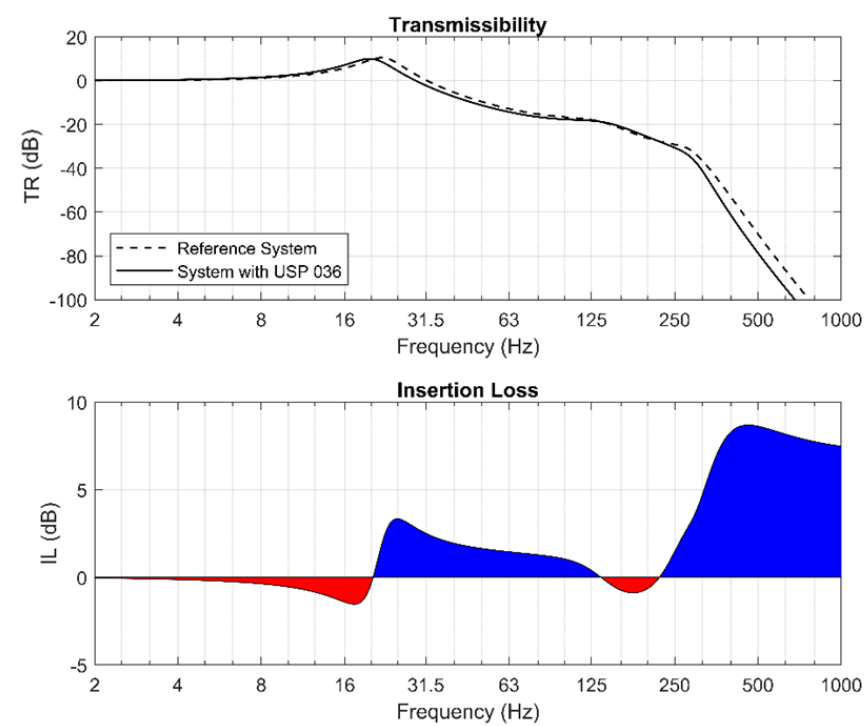
Figure 9. Transmissibility and insertion loss: reference system and system with USP 036.